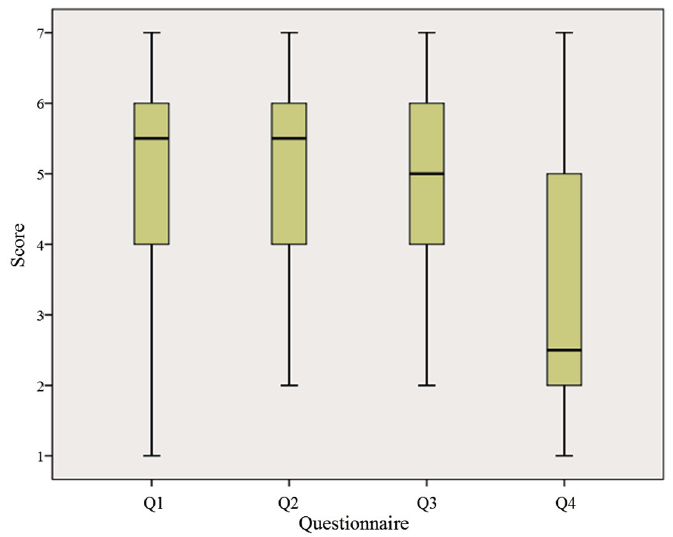
Figure 9. Results of the